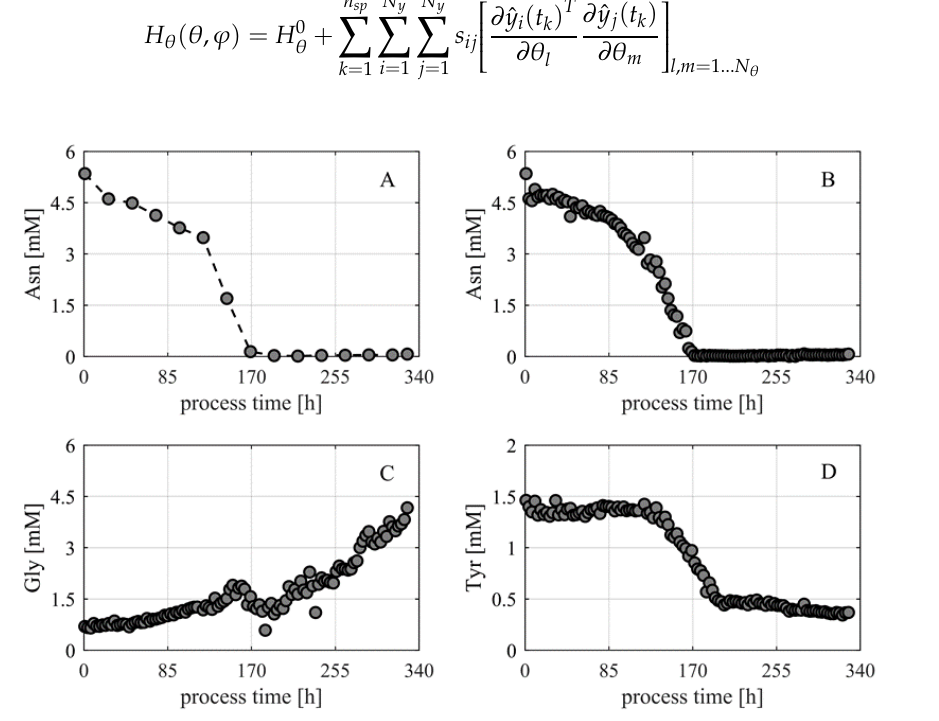
Figure 7. Examples of amino acid concentrations monitored in an automated manner during a CHO cultivation. Plot ( A ) shows the asparagine concentrations received when sampled once per day; plot ( B ) when sampled 8 times per day. High-frequency sampling allows better interpretation of the underlying uptake kinetics. Plot ( C ) shows glycine over time and plot ( D ) tyrosine over time, which was